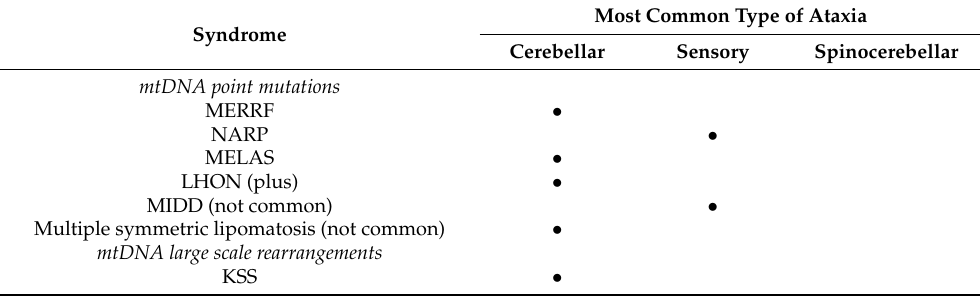
Table 2. Ataxia in mtDNA-related